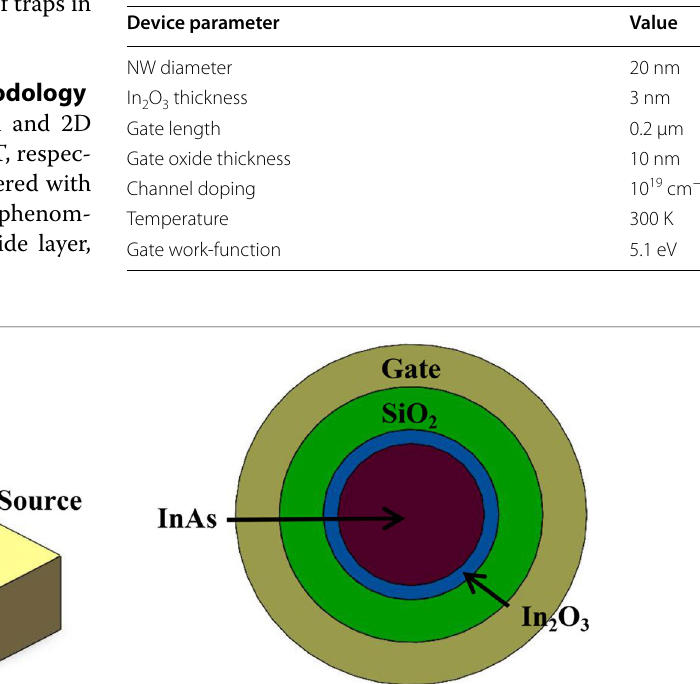
Table 1 Main parameters of a GAA InAs NW